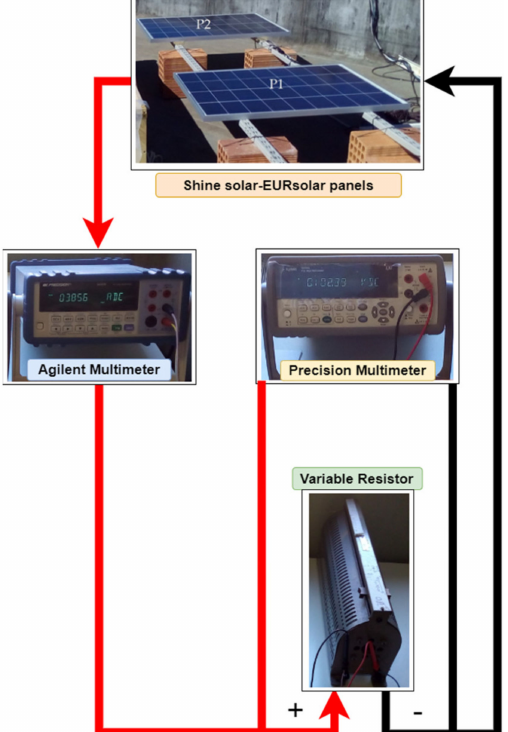
Figure 3. PV panels characterization scheme.